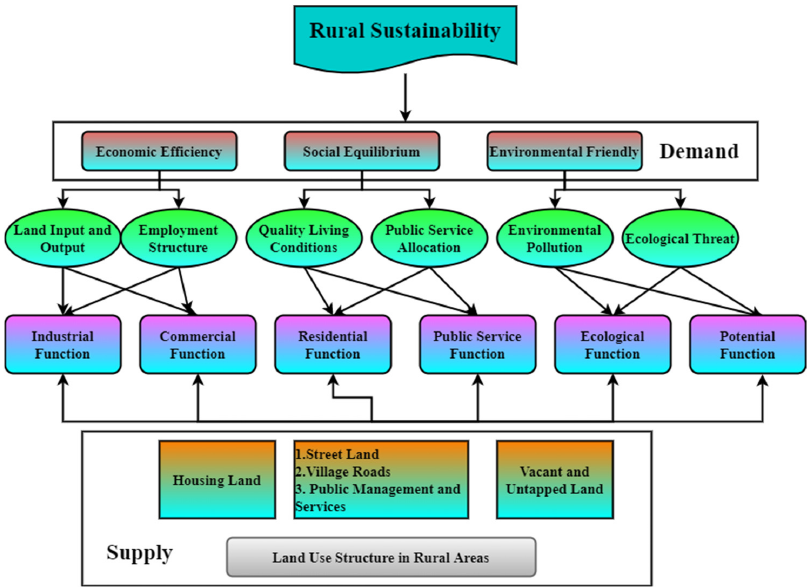
Figure 4. Rural sustainability based on land use structure in rural regions. Land function refers to the function of land that can meet the needs of human pro- duction, life, and other aspects. The land has the function of breeding, providing the en- vironment for plants to survive, and humans can also carry out agricultural planting ac- tivities on the land to provide crops for humans to achieve land use. The space bearing function of land provides a stable space for human activities and production, enabling